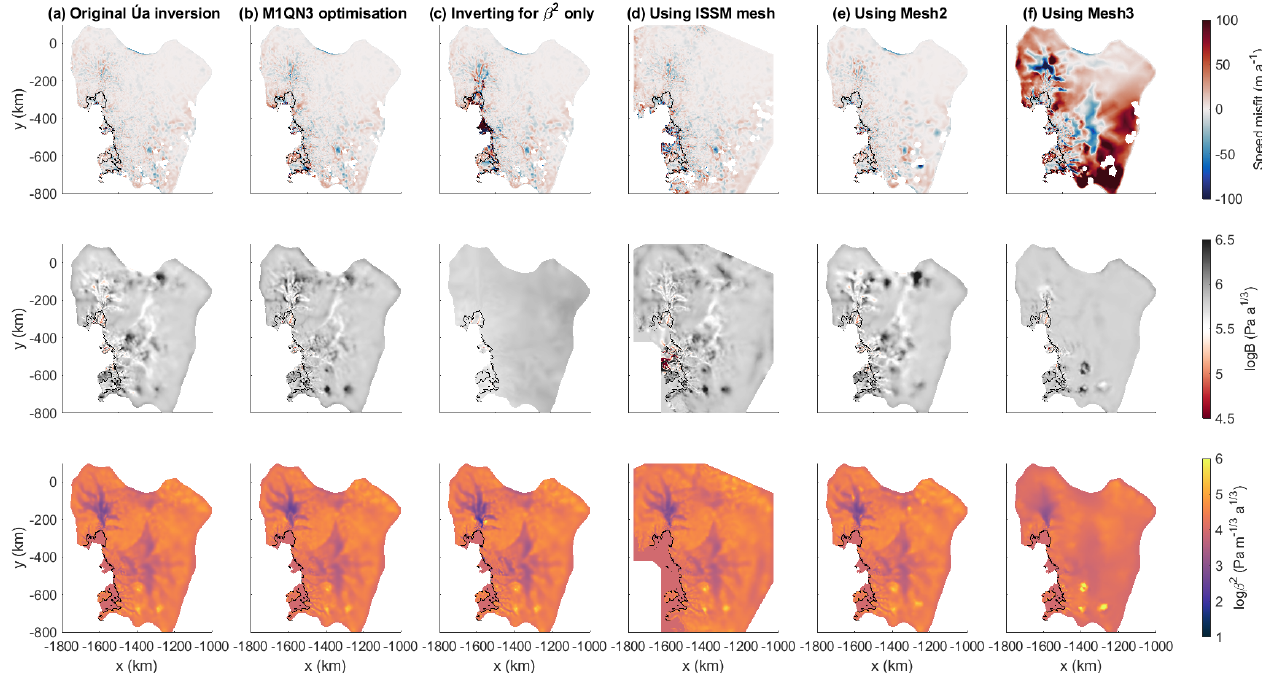
Figure B2. A comparison of the speed misfit, rate factor and basal sliding coefficients for several cases of inversions in Úa under different conditions. (a) The original Úa inversion for B and β 2 using an interior-point optimisation scheme. (b) The inversion using the M1QN3 optimisation scheme. (c) Inverting for β 2 only, using ISSM’s B field. (d) Using the mesh and domain of the original ISSM inversion. (e) Using the second (coarser) version of Úa’s mesh. (f) Using the third (even coarser) version of Úa’s mesh. Table B1. The Pearson correlation coefficients of various models and tests with Úa’s original inversion. The first two columns show the correlation of the original ISSM and STREAMICE inversions, and the remaining columns show the correlation with the cases displayed in Fig. B2b–f. ISSM STREAMICE M1QN3 β 2 only ISSM mesh Mesh2 Mesh3 Speed misfit correlation 0.270 0.474 0.980 0.021 0.743 0.963 0.863 B correlation (whole domain) 0.077 0.058 0.238